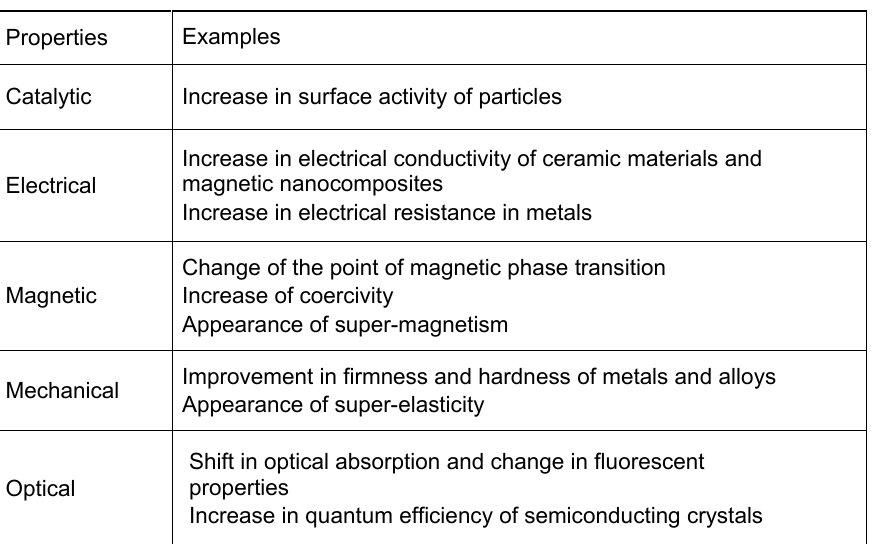
Table 1 – Some of the common properties of nanomaterials that are significantly different from the properties of the bulk materials with the same chemical composition (Nass et al, 2004,